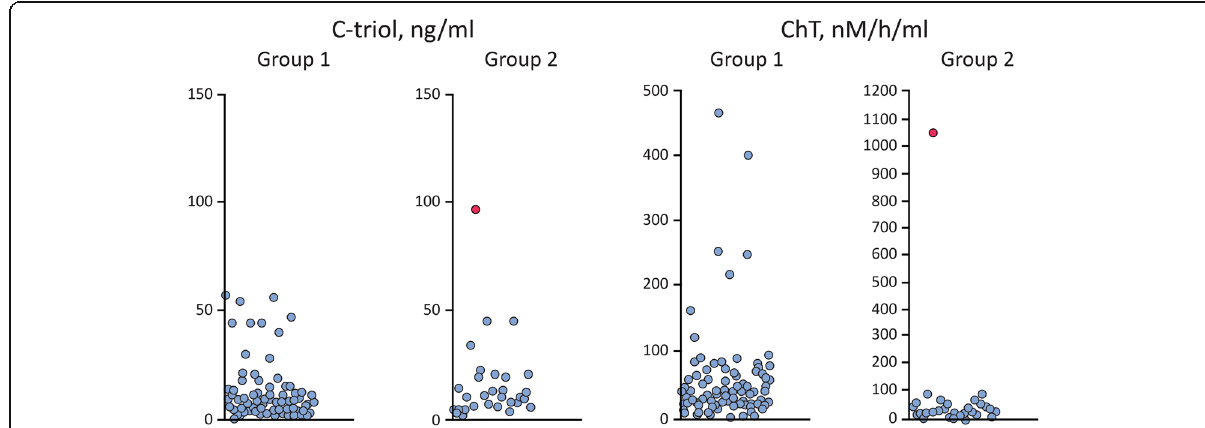
Fig. 1 Distribution of C-triol concentration and ChT activity. Footnote: The red-shaded data point signifies the NP-C